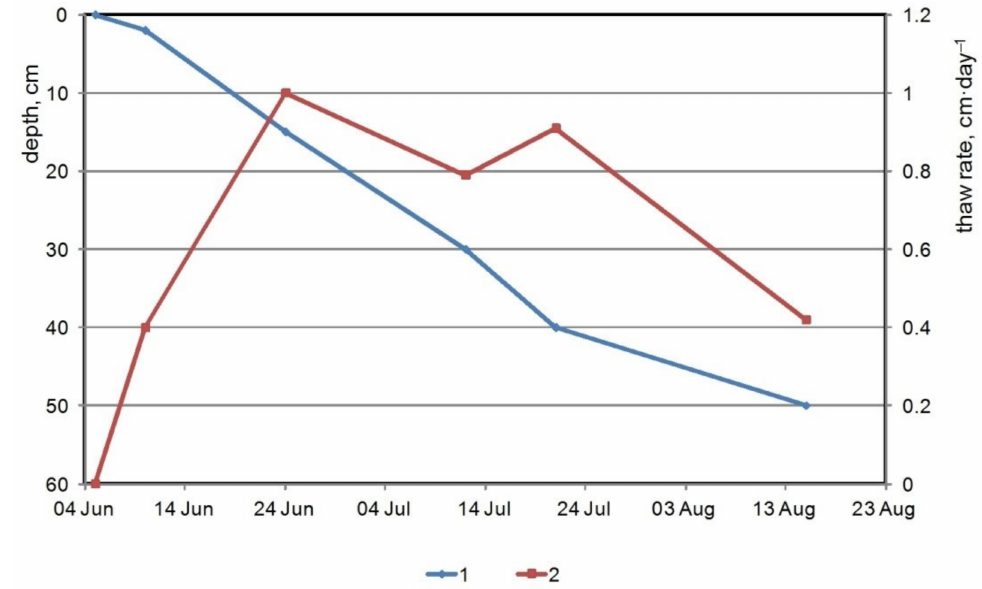
Figure 2. Depth (1) and seasonal soil thawing rate (2) in the Anadyr Lowland hummocky tundra.